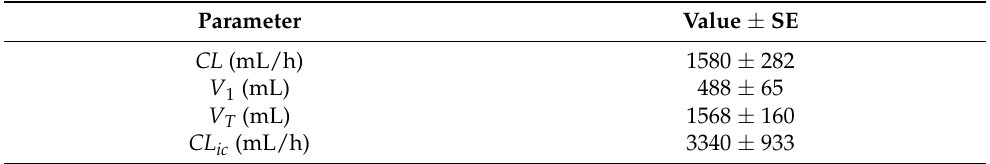
Table 1. Pharmacokinetic parameters (two-compartment model) obtained in rats dosed intravenously with NT.